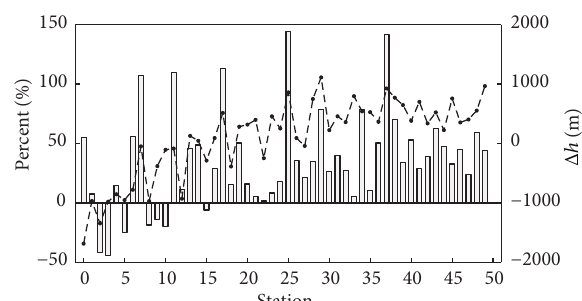
Figure 2: Annual precipitation bias (bars) between ERA-Interim and MeteoSwiss stations in percent for the period 1983–2010. Pos- itive values indicate an overestimation of the annual precipitation by ERA-Interim and vice versa. The line with dots indicates altitude differences, Δℎ , defined as ERA-Interim grid height minus site elevation.